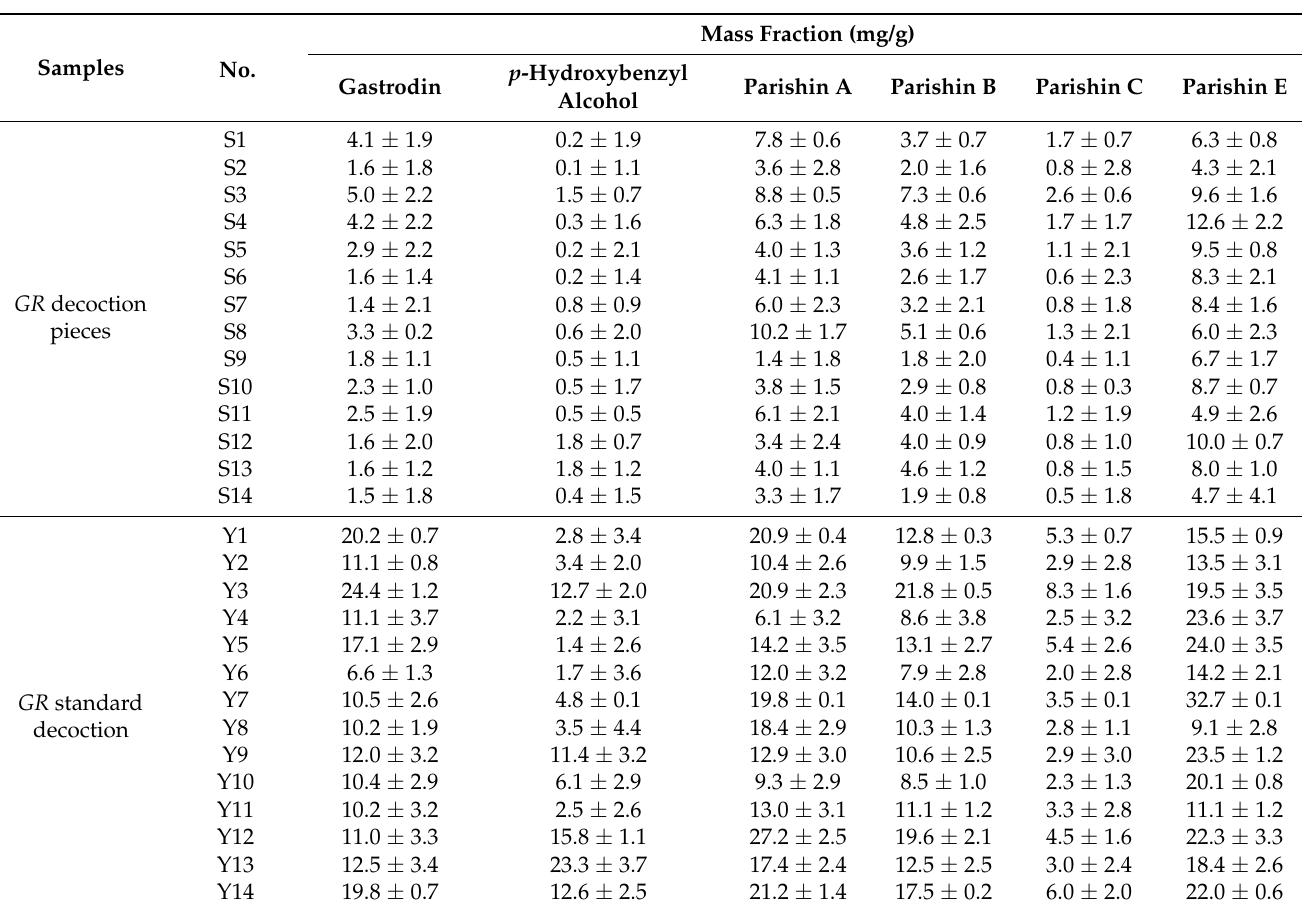
Table 2. Contents of six components in 14 batches of GR decoction pieces and standard decoctions ( n =